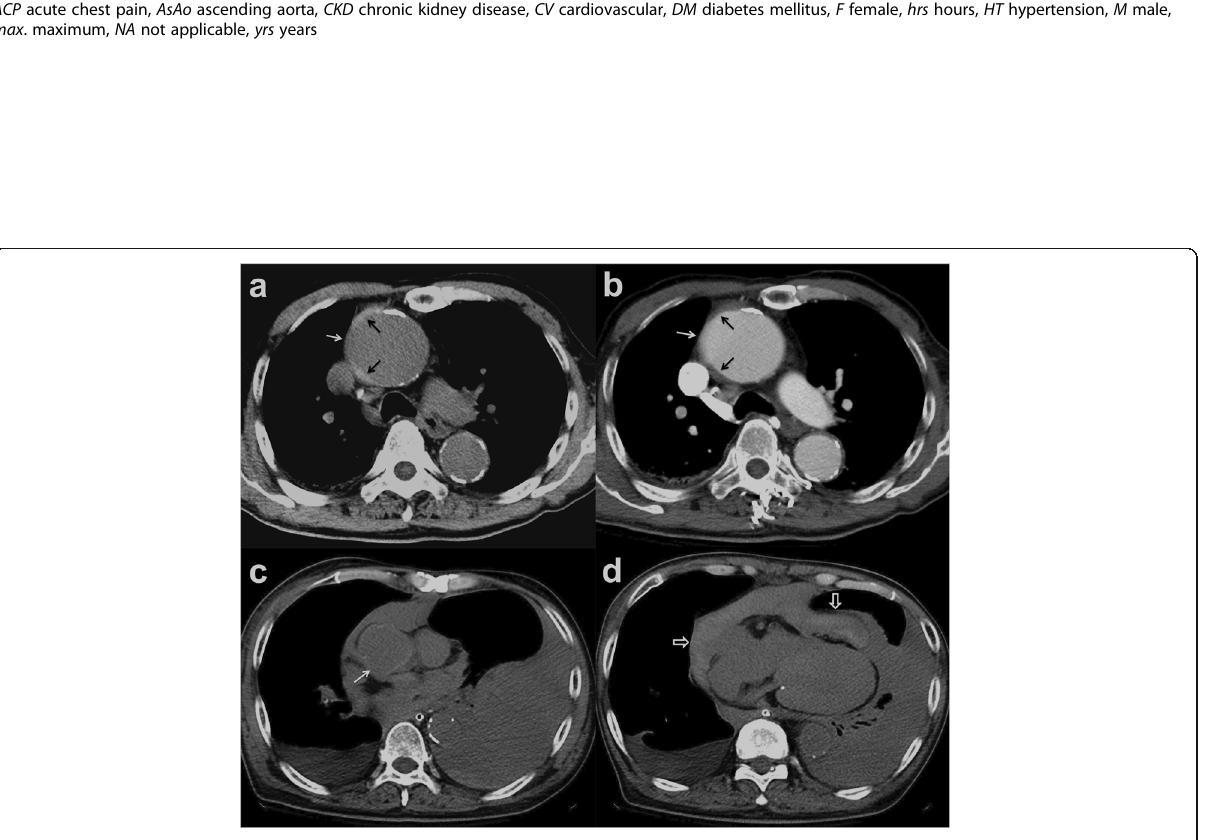
Fig. 2 a Unenhanced axial CT shows a smooth central defect (white arrow) in the hyper-attenuating crescentic hematoma (black arrows) along the ascending thoracic aorta. b Enhanced CT shows a focal out-bulging (white arrow) of the aortic lumen, with smooth obtuse edges corresponding to the defect on unenhanced study and non-enhancing crescentic hematoma (black arrows). Note the absence of intimal flap or contrast medium extravasation. c , d Unenhanced follow-up CT shows rupture of the ascending aorta (white arrow), hemopericardium (open arrows), and left pleural